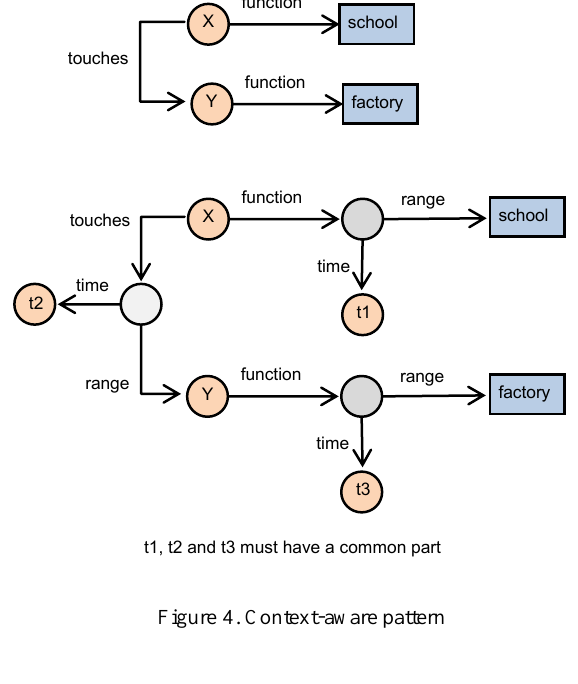
Figure 4. Context-aware